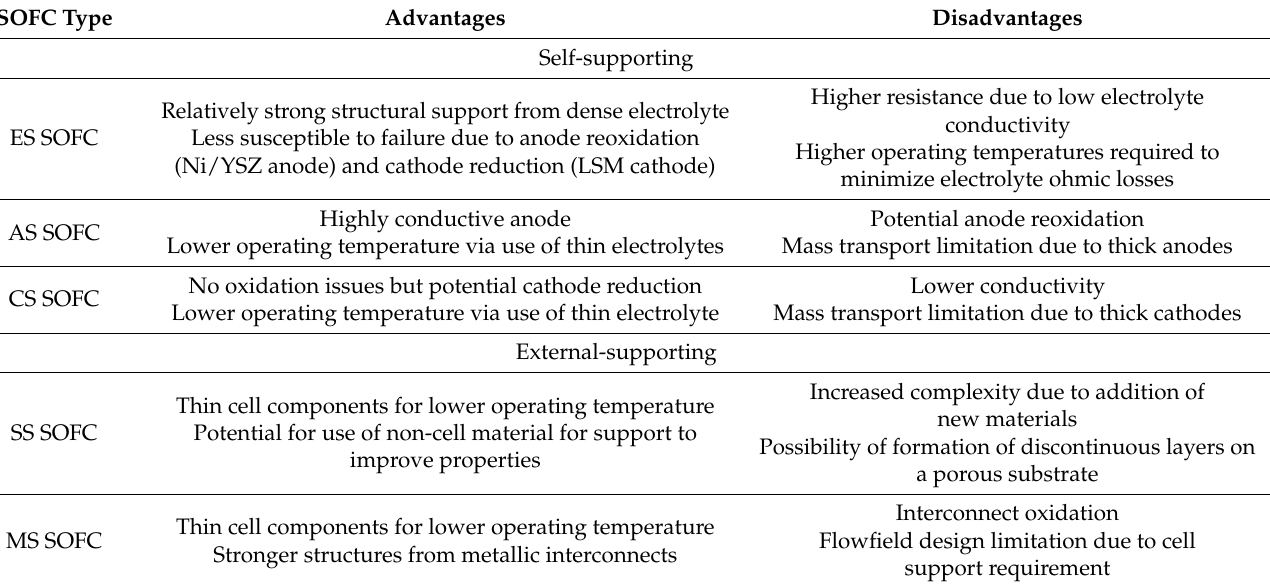
Table 3. Features of SOFC with the different supporting